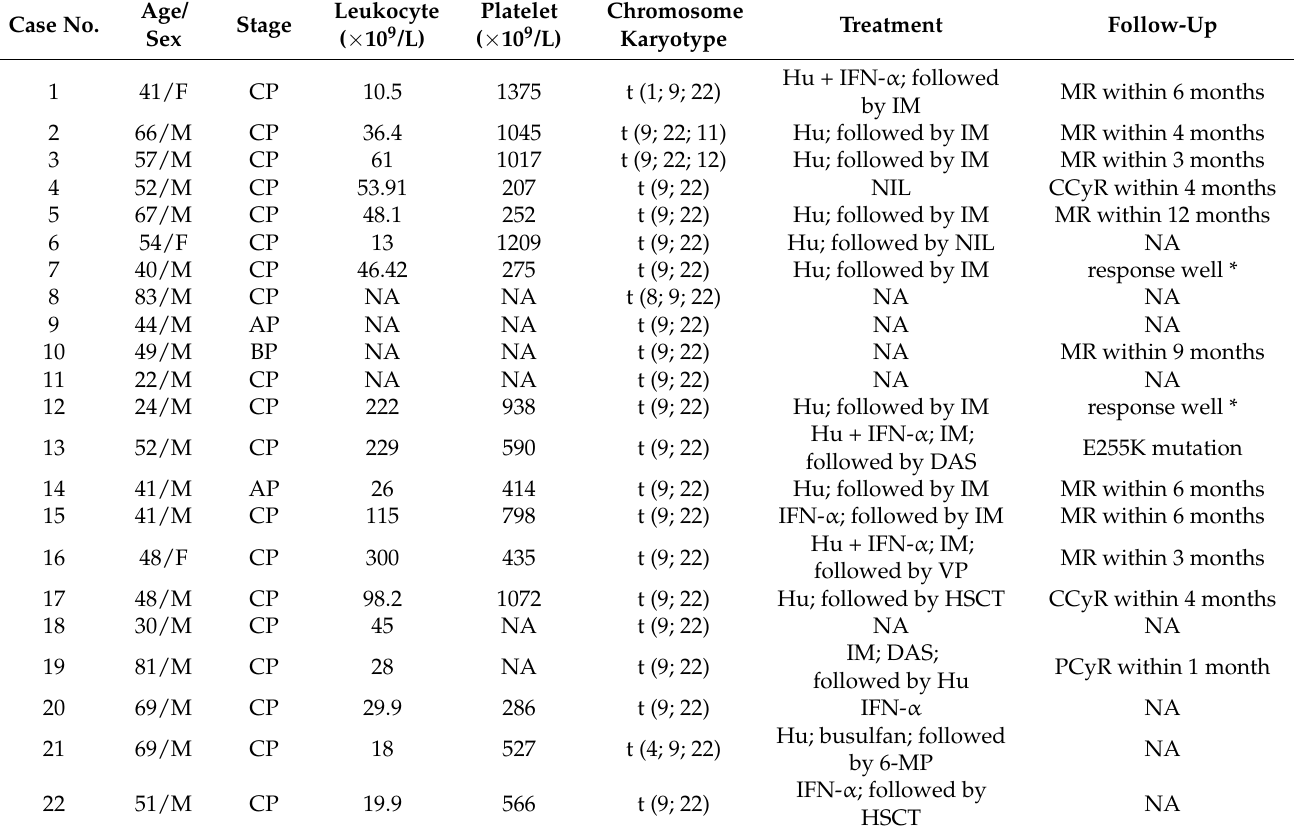
Table 2. The characteristics of 25 CML patients with e14a3 (b3a3) BCR::ABL1